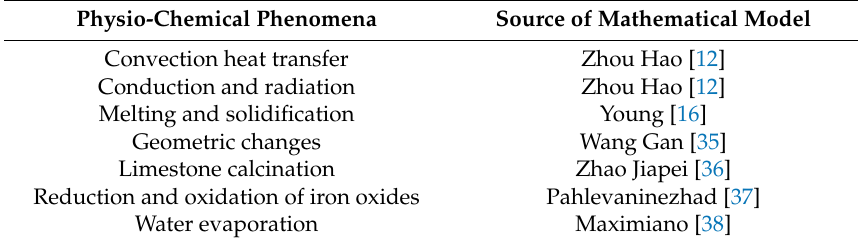
Table 1. Summary of mathematical models used in the present simulation.